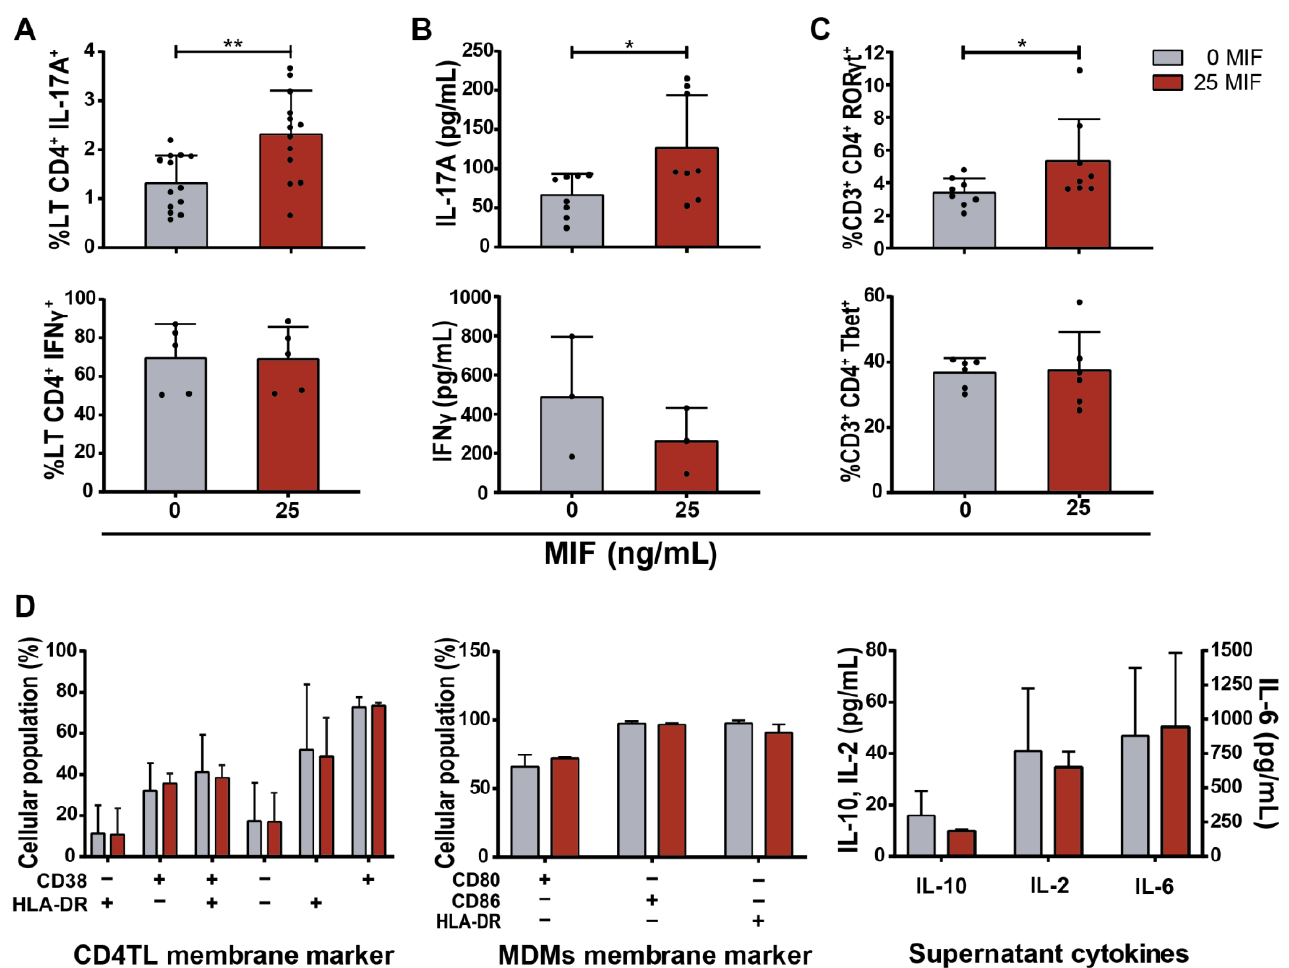
Figure 1. Activation status of HIV-infected MDMs after MIF stimulus. ( A ) Concentration of IL-6, IL- 1β IL -10 and IL-8 in supernatants from HIV-infected MDMs treated (dark red lines) or not (grey lines) with MIF. ( B ) CD80, CD86 and HLA-DR surface expression on HIV-infected MDMs treated (dark red bars) or not (grey bars) with MIF after 72 and 120 h of stimulus. Data show the mean ± SD of three independent experiments each one performed in triplicate. Data analysis was performed by one-w ay ANOVA and Sidak’s post -test. * p < 0.05, ** p < 0.01, *** p < 0.001, **** p < 0.0001.